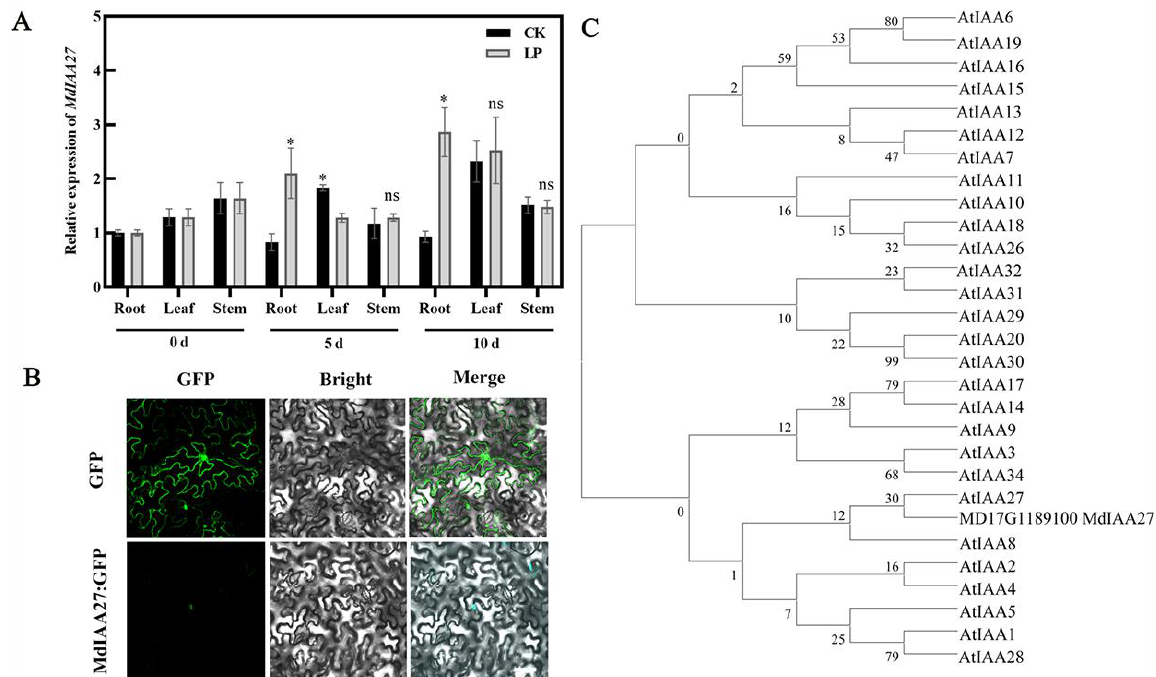
Figure 2. Expression characteristics of MdIAA27. ( A ) The qRT-PCR analysis of MdIAA27 expression in root, leaf and stem under low phosphorus conditions. * indicates statistically significant differ- ences at p ≤ 0.05. ns indicates no significant difference between each group. Error bars indicate standard deviation (s.d.) from three biological replicates. ( B ) Subcellular localization of MdIAA27 in tobacco leaf cells. Scale bars: 10 μm. ( C ) Phylogenetic analysis of MdIAA27 with Aux/IAA pro- teins from Arabidopsis.